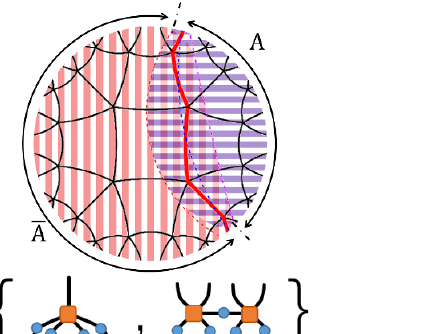
Figure 17 . The tensor network with f 4 ; 5 g tiling and S c =